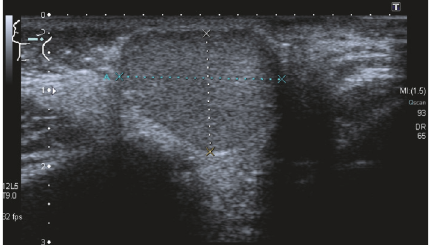
Figure 1: Ultrasonography of the left parotid gland showing a well- defined, homogenic, round, and hypodense mass with a diameter of 2.5 × 2 × 1.9